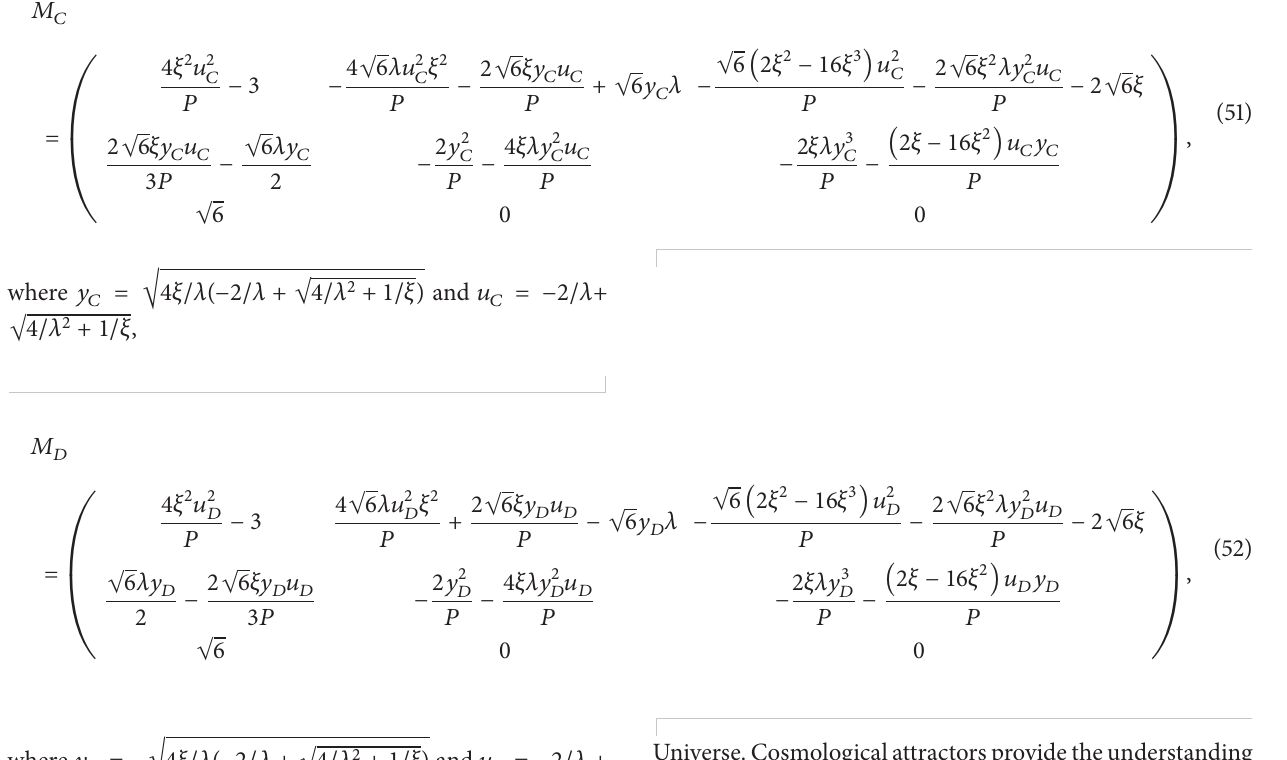
we illustrate the 2-dimensional projections of 4-dimensional phase-space trajectories for the stability condition 𝜉 = 0.15 and for the present day values 𝛽 = 14.5 , 𝛾 = 1.5 , and Ω 𝑚 = 0.3 and three auxiliary 𝜆 values. This state corresponds to a stable from the plots in Figure